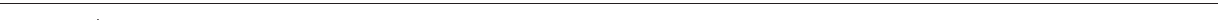
FIGURE 1 | illustration of the complement system shows its most relevant activators (in black font) and inhibitors (in red). The activators may be membrane bound (oval) or soluble (triangle). The alternative pathway activates spontaneously on all surfaces that do not allow for inhibition by the soluble regulator factor H (FH). FH acts as the cofactor for inactivation of C3b to iC3b by factor I (FI). Thrombomodulin (TM) enhances FH cofactor activity. Cleaved factor B (FB) together with the activator C3b forms the alternative pathway convertase, which has the capacity to cleave C3 into C3b creating an amplification loop of alternative pathway activation. Classical pathway of complement activation may be initiated by for example binding of immune complexes to C1q, while the lectin pathway is activated by mannoses binding lectin (MBL) or ficolins binding to for example patterns of carbohydrates on microbes. Lectin pathway activation results in mannose-associated serine proteases 1 and 2 (MASP-1 and MASP-2, not pictured) cleaving complement components C4 and C2 to form the classical pathway convertase C4bC2b. C1 inhibitor (C1inh) and C4bp are the soluble regulators of the classical pathway, while membrane cofactor protein (MCP) and complement receptor 1 (CR1) are membrane bound regulators of early complement pathways. The formation of C5 convertases initiates the terminal pathway of complement activation and cleavage of C5 in the absence of surface bound regulators decay accelerating factor (DAF) and MCP. Assembly of MAC is regulated by the surface bound regulator CD59 (protectin). Cleavage of C3 in the early pathways and C5 in terminal pathway releases anaphylatoxins C3a and C5a and results in inflammation. Eculizumab is a humanized recombinant antibody against the complement protein C5, which inhibits cleavage of C5 by the C5 convertases thereby regulating the prothrombotic and proinflammatory effects of complement activation. The patient described in this case report was tested for genetic mutations in genes coding for Factor H ( CFH ), FHR5 , and MCP , CFI , CFB , THBD , and ADAMTS13 ( ADAMTS13 ), a regulator of the vWF pathway of coagulation cascade (not shown). The results of the genetic testing were negative.